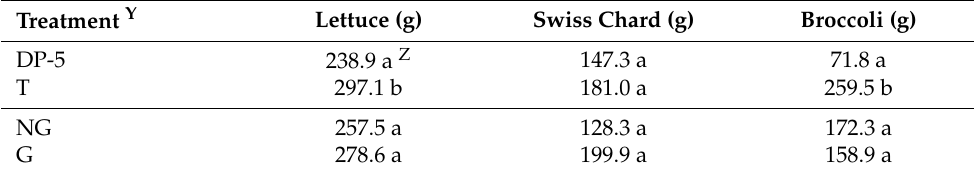
Table 1. Cumulative yield of vegetables grown in a bermudagrass lawn in 2014. Treatment